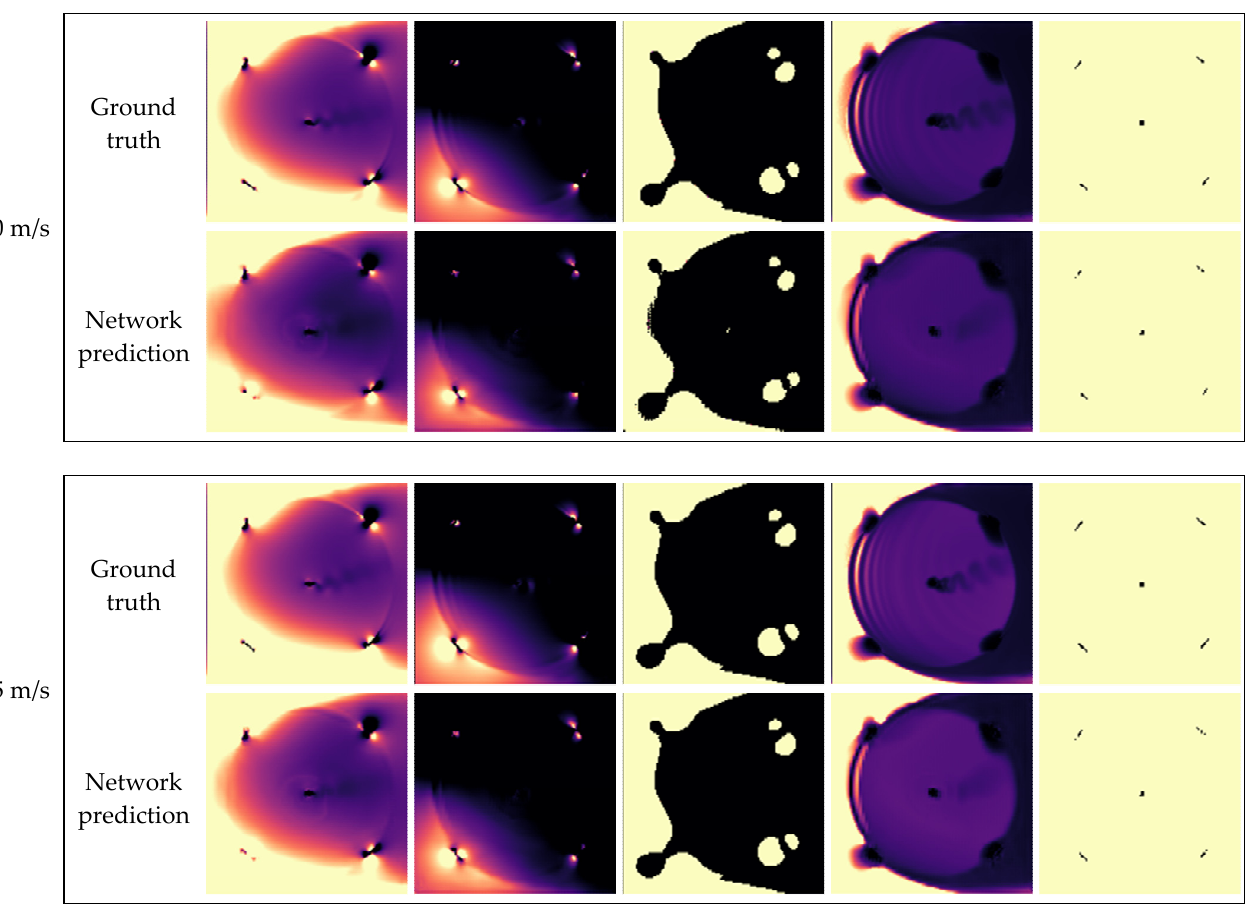
Figure 23. Ground truths and network predictions of Model 2 for the testing cases of v ∞ = 1.5, 2.0, and 2.5 m/s.